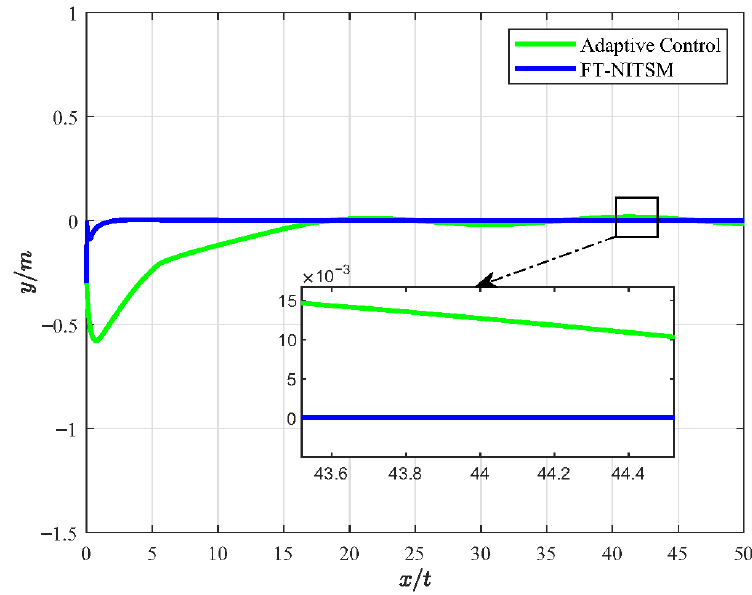
Figure 5. Comparison of resonant frequency tracking performance of FT-NITSM control and adap- tive tracking control.